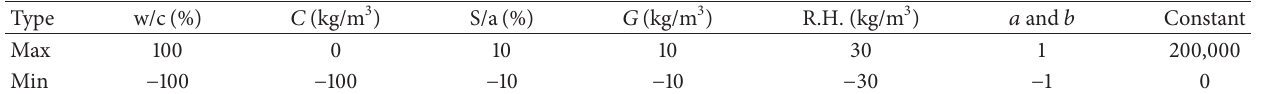
Table 5: Variables for fitness